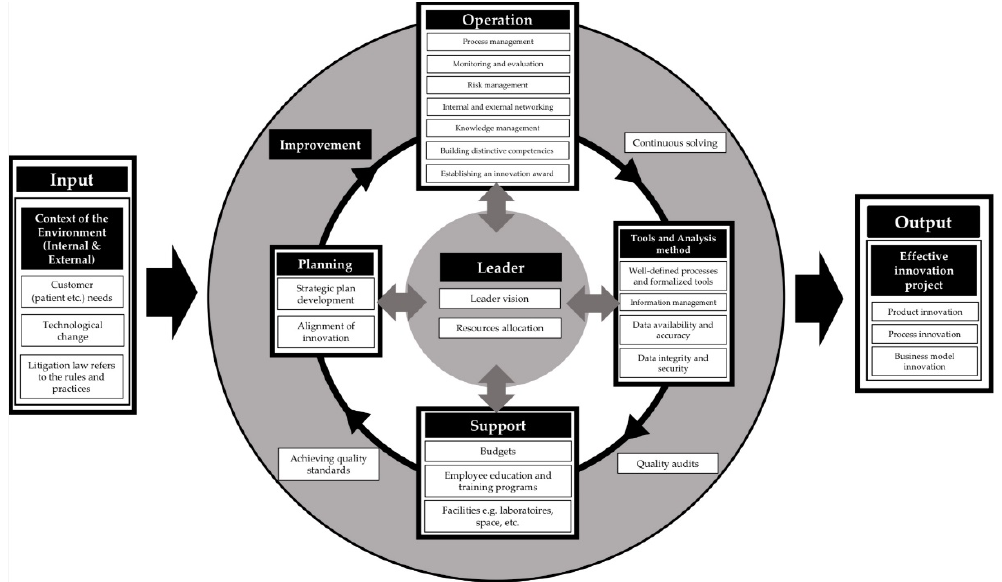
Figure 5. The conceptual framework of TQIM-H .